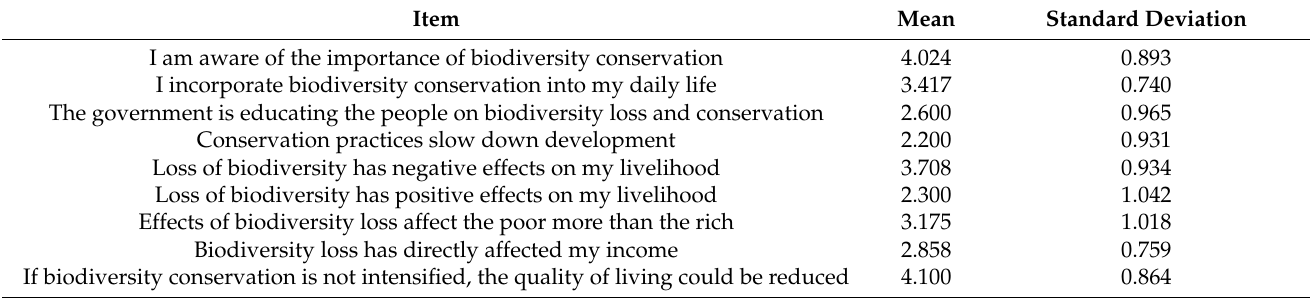
Table 2. Perception of biodiversity, importance, and effects on livelihoods.